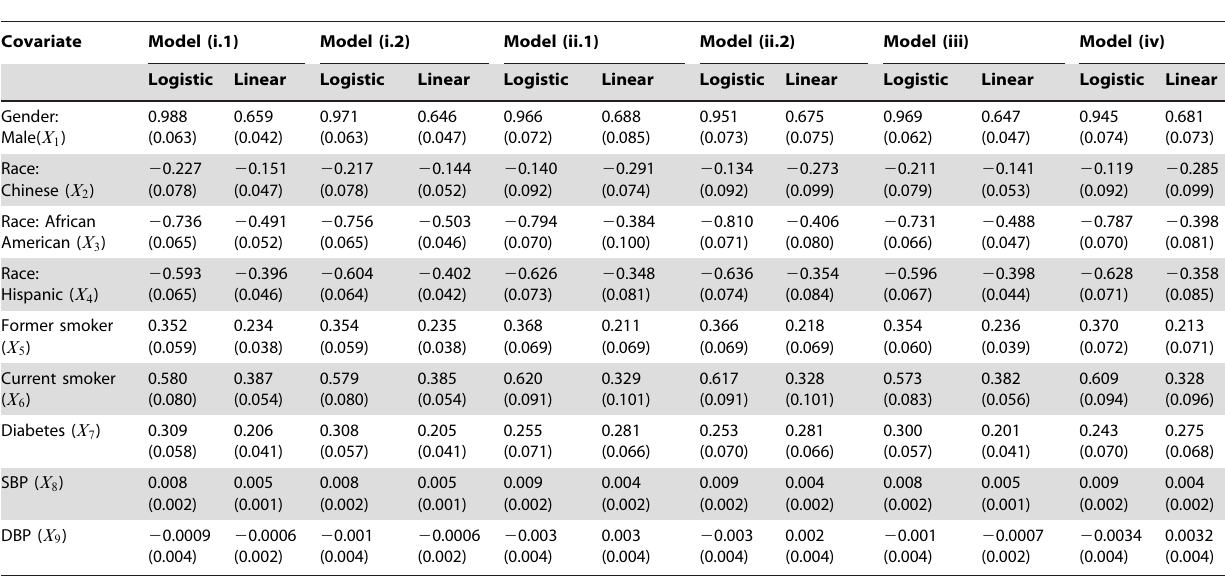
Table 1. Estimated regression coefficients (standard errors) for covariates with parametric effects in all